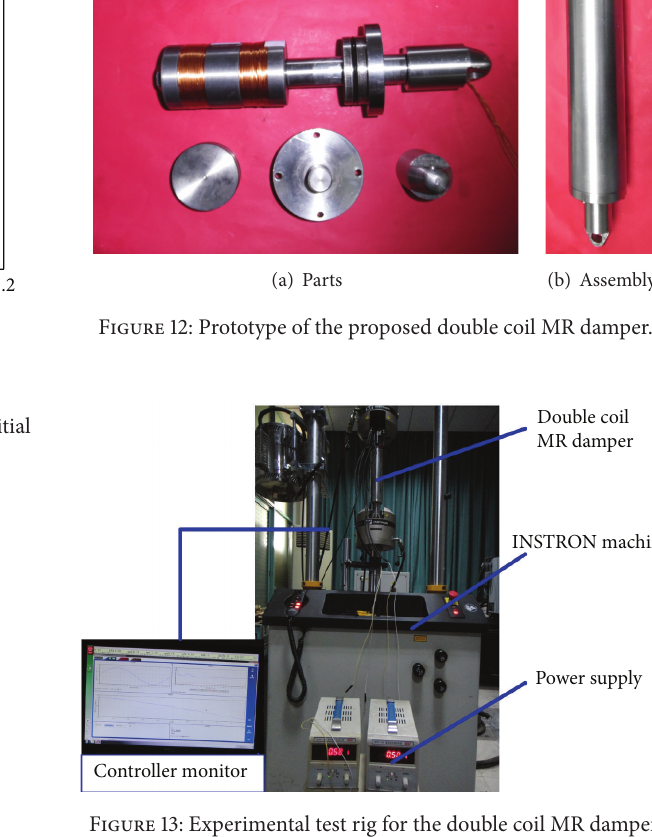
Figure 13: Experimental test rig for the double coil MR damper.